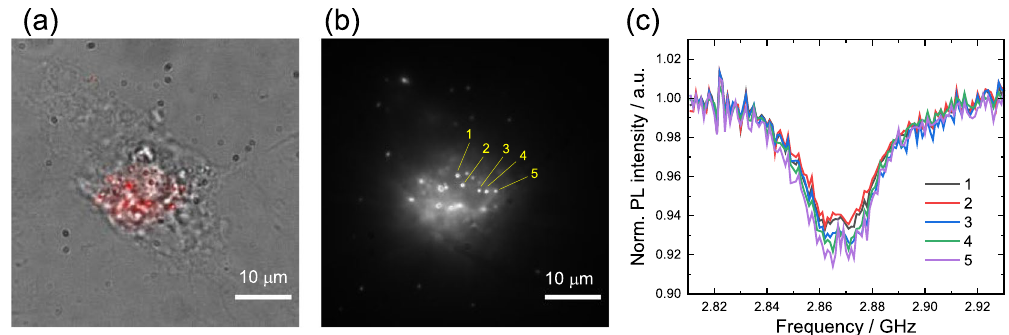
Figure 6. Microscope images of living ND-labeled HeLa cells; ( a ) merged (bright field and red fluorescence) and ( b ) red fluorescence only. ( c ) ODMR spectra of NDs 1 – 5 . n acc = 50 and (cid:31) t exp = 10 ms were used for all the